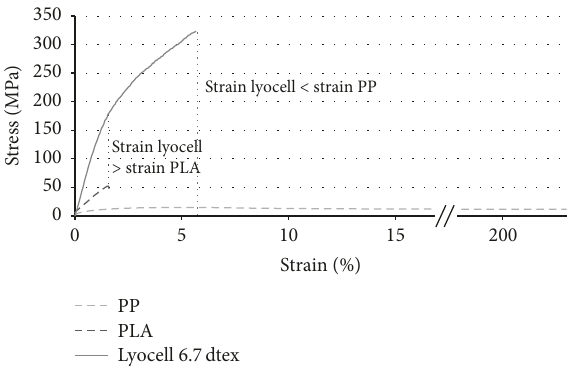
Figure 10: Typical stress-strain curves of neat PLA, neat PP, and lyocell